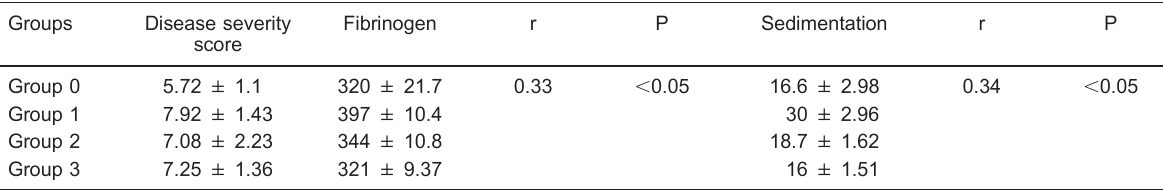
Table 2. Correlation between disease severity score and acute-phase reactants in study groups.